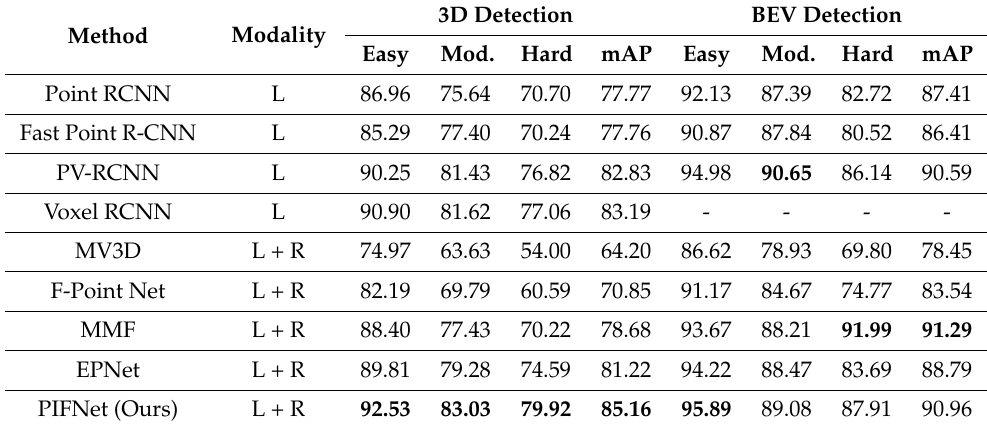
Table 1. Comparisons with state-of-the-art methods on the testing set of the KITTI dataset (Cars). L and R represent the LiDAR point cloud and the RGB image.